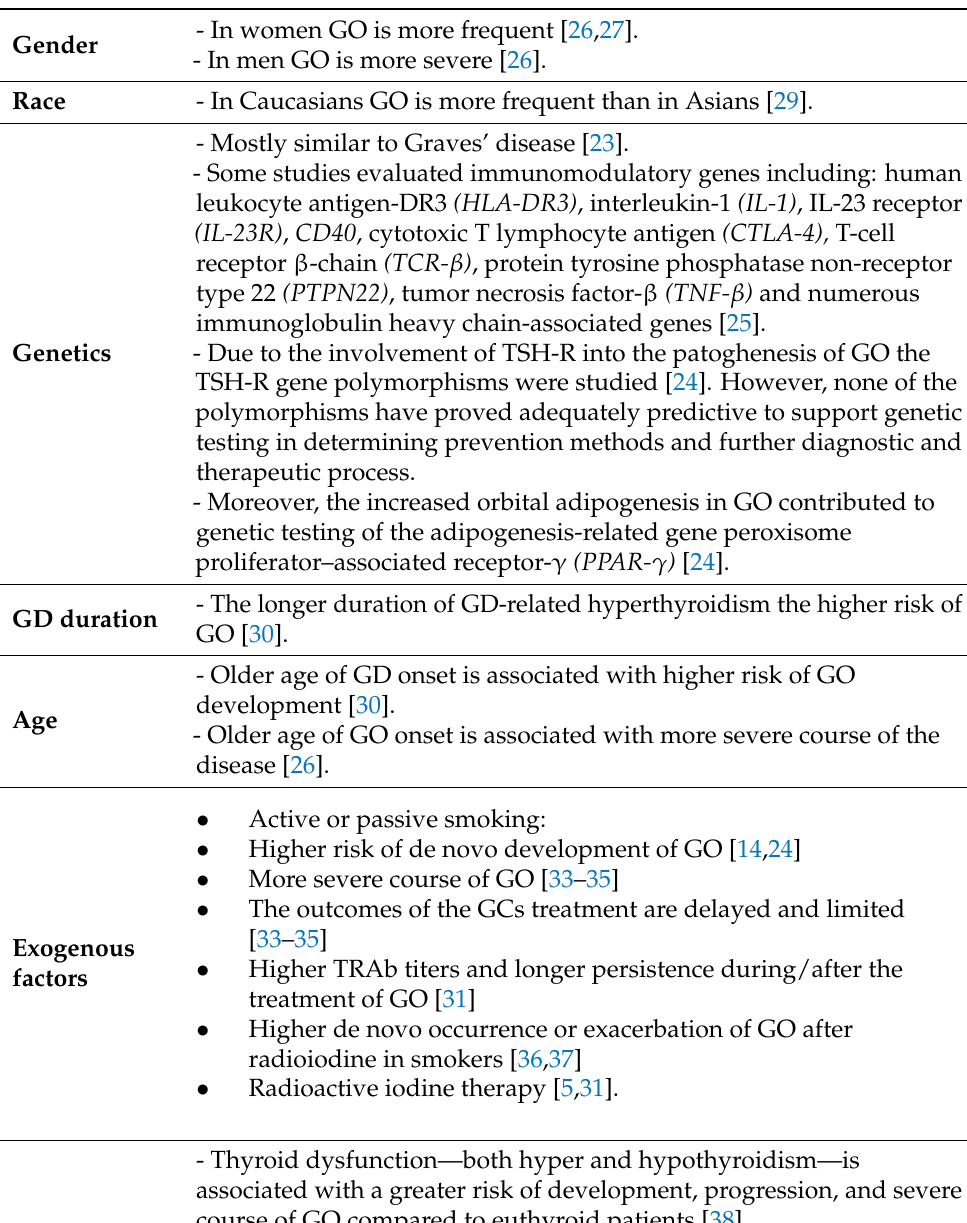
Table 1. This Risk factors for Graves’